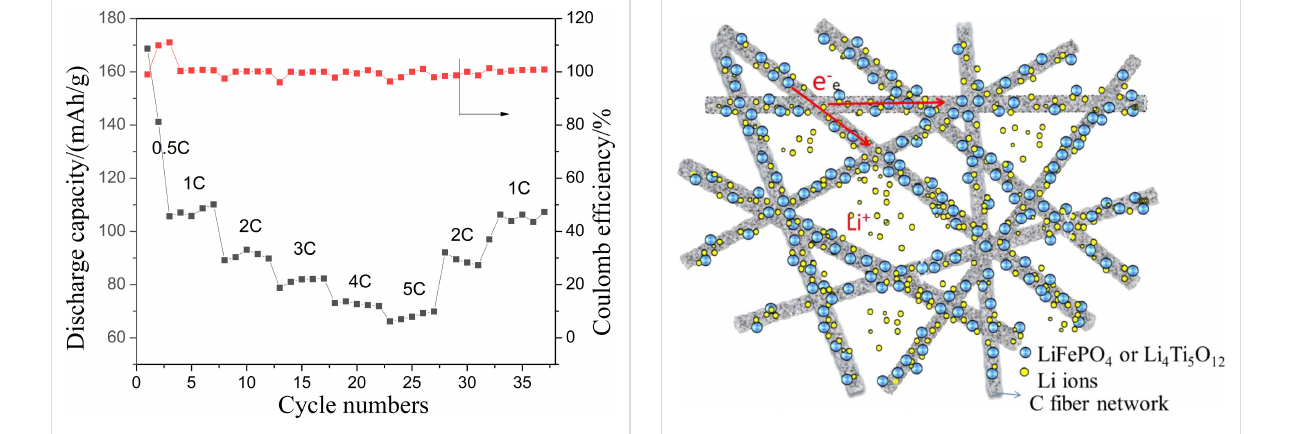
Figure 13: Rate performance of the LiFePO 4 //Li 4 Ti 5 O 12 all-fiber battery.